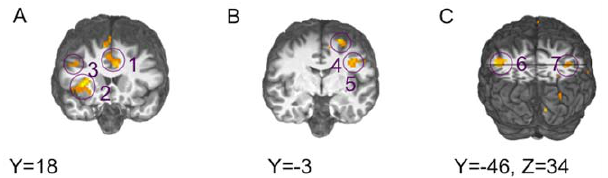
Figure 4. Brain regions showing main effects of FEEDBACK- EVOKED BEHAVIOR (stay vs. shift) on BOLD responses, in the entire sample (Talairach coordinates of each slice listed at the bottom of each panel). Decisions to shift to the alternate stimuli following negative feedback were associated with activations (relatives to stays) in ( A ) dmPFC, R dlPFC, R vlPFC, ( B ) premotor cortex, and ( C ) posterior parietal cortex.